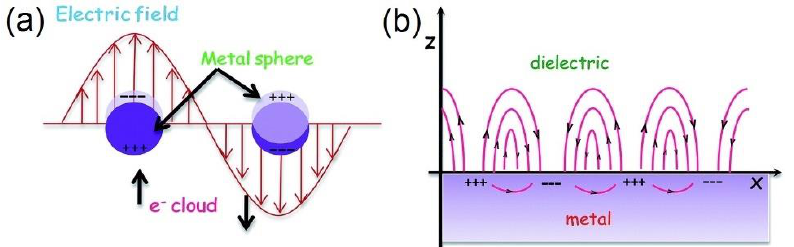
Figure 4. Schematic illustrations of ( a ) Localized Surface Plasmon Resonances and ( b ) Surface Plasmon Polaritons. Note the differences in morphologies of the structures involved. LSPRs are excited on metal nanostructures smaller than the electron mean free path within the material as well as smaller than the wavelength of incident light, such as the nanospheres in ( a ) where free electrons are displaced from the positive ions, driven by the propagating electric field component of the incident light, and oscillate collectively in resonance. In ( b ) the metal surface’s characteristic dimension is larger than the wavelength of incident light resulting in the excitation of a propagating surface plasmon polariton that travels along the surface with evanescent waves that diminish perpendicular to the surface. Reprinted with permission from Ref [120] Copyright Royal Society of Chemistry